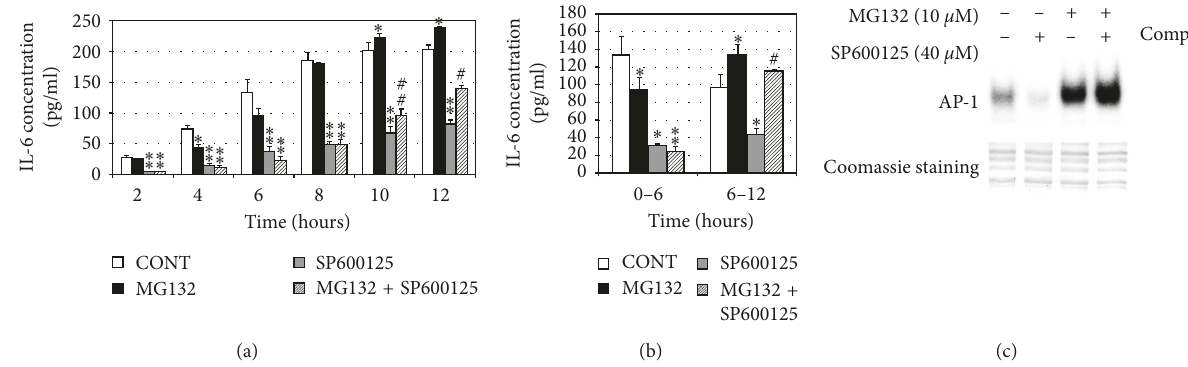
Figure 6: Inhibition of JNK cannot block proteasome inhibition-induced upregulation of IL-6. (a) ARPE-19 cells were cultured in the presence or absence of MG132 (10 μ M), Sp600125 (40 μ M), or MG132 plus Sp600125 for 2, 4, 6, 8, 10, and 12 h. Levels of IL-6 in the media were determined by ELISA. The results are the mean ± SD. ∗ p < 0 . 05 and ∗∗ p < 0 . 01 as compared with the control; # p < 0 . 01 as compared with the control or Sp600125 alone; ## p < 0 . 05 as compared with the control or Sp600125 alone. (b) Levels of IL-6 in the medium were detected by ELISA at 0h–6h and 6h–12 h in the presence or absence of MG132 (10 μ M), SP600125 (40 μ M), or MG132 plus SP600125. The results are the mean ± SD. ∗ p < 0 . 05 and ∗∗ p < 0 . 01 as compared with the control; # p < 0 . 05 as compared with the control or Sp600125 alone. (c) To study whether JNK inhibition can block the activation of AP-1 induced by proteasome inhibition, the RPE cells were cultured in the presence or absence of MG132 (10 μ M), SP600125 (40 μ M), or MG132 plus SP600125 for 4h; nuclear extracts were prepared; and electrophoretic mobility gel shift assays were performed for AP-1 binding. Coomassie staining gel was the internal